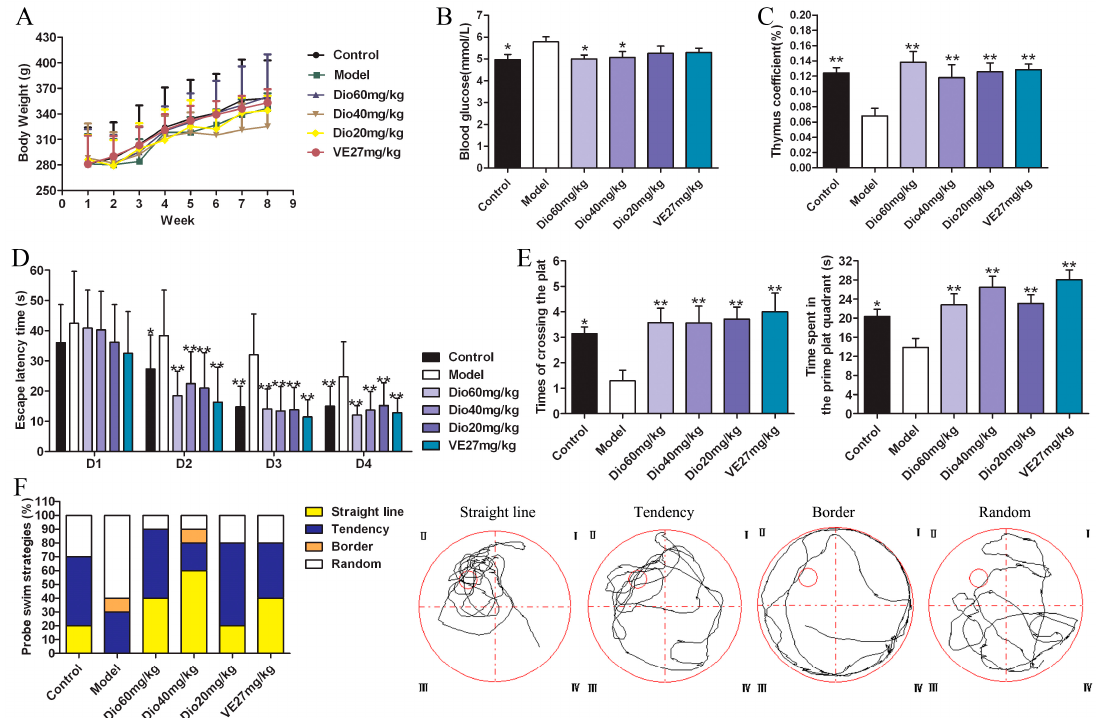
Figure 2. Effects of dioscin on D -galactose induced aging in rats. ( A ) Effects of dioscin on body weights. ( B ) Effects of dioscin on blood glucose. ( C ) Effects of dioscin on thymus gland. ( D ) Effects of dioscin on aging rats in the hidden platform experiment in the WMW test. ( E ) Effects of dioscin on aging rats in the probe trial in the WMW test. ( F ) Effects of dioscin on terms of search strategy in the WMW test. Data are presented as the mean ± SD (n = 10). * p < 0.05 and ** p < 0.01 compared with model